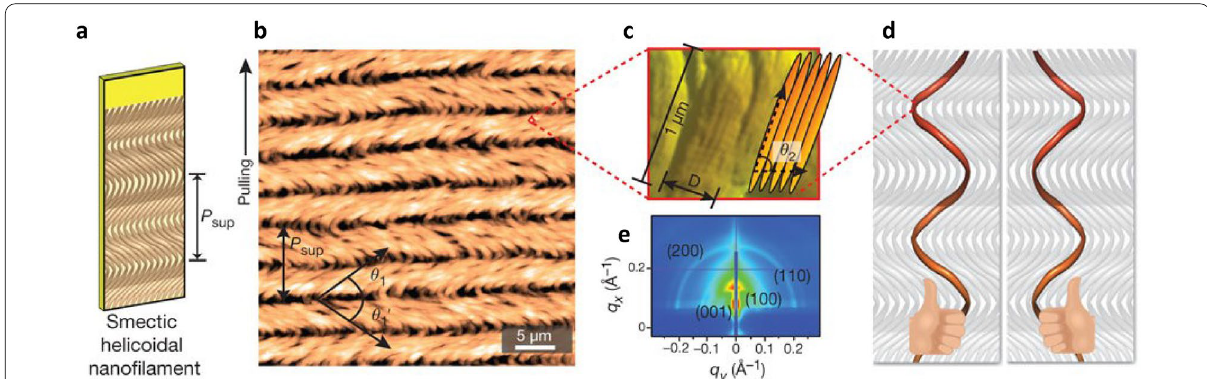
Fig. 3 The nanostructure of smectic helicoidal nanofilament. a Diagram of smectic helical nanofilament (SHN) structure. Atomic force microscopy (AFM) images of b SHN structures composed of c smectic C bundles. d Proposed model of SHN structure composed of left‑ and right‑handed helix nanofilaments. e Grazing incidence small‑angle X‑ray scattering measurements perpendicular to the pulling direction show phage structures filled with quasi‑hexagonal within the SHN ( a – e Reproduced with permission from Ref. [60]. Copyright 2011, Nature Publishing